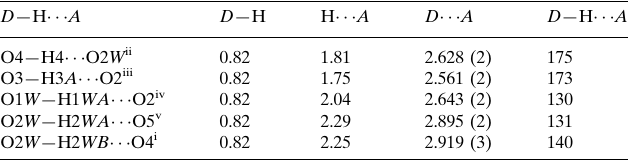
Hydrogen-bond geometry (A˚ , (cid:2)